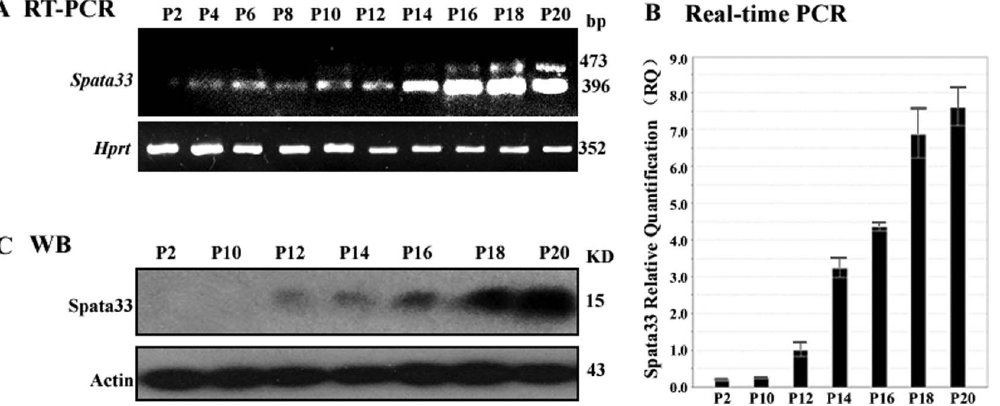
Figure 4. Expression of Spata33 mRNA and protein in the postnatal testes of mice. A). RT-PCR showed expression pattern of Spata33 mRNA in testes from P2 to P20 (postnatal days). Total RNAs were isolated from mouse testes and then cDNAs were synthesized. Hprt was used as an internal control. Molecular weight is shown on the right. Spata33 mRNA was increased markedly after P12. B). Real-time fluorescent quantitative PCR of the Spata33 in testes from P2 to P20. Error bars indicate the standard deviation (SD) of the mean (n=3). Y-axis represents relative expression levels of Spata33 and X-axis shows different development stages P2-P20. C). Expression of Spata33 protein in testes from P2 to P20. Mouse testes were individually collected from aged 2 to 20 days and were subjected to Western blot analysis with antibody against Spata33. The protein level was markedly increased from P12. Actin was used as an internal control. Molecular weight is shown on the right. All experiments were performed three times with independent